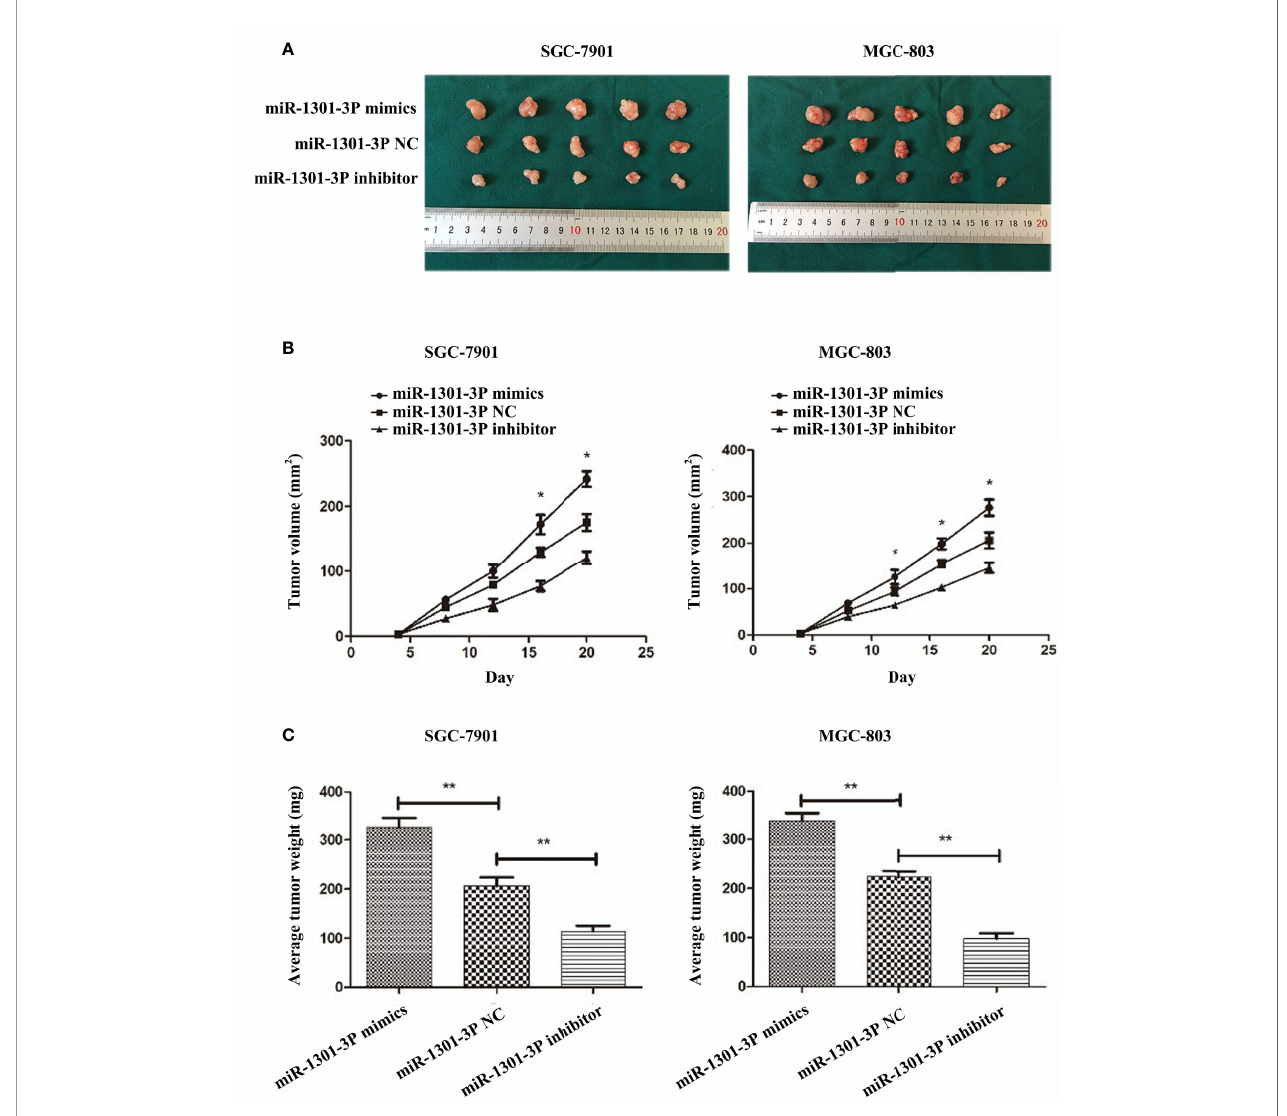
FIGURE 9 | miR-1301-3p facilitates tumor growth of GC cells in vivo . (A) GC cells SGC-7901 and MGC-803 transfected with miR-1301-3p mimics facilitated the tumor formation in the fl ank of nude mice, GC cells SGC-7901 and MGC-803 transfected with miR-1301-3p inhibitor retarded the tumor formation in the fl ank of nude mice. (B, C) The graphs represented the growth tendency of tumors 3 weeks after inoculation. The volume and weight of tumors were calculated. *p < 0.05, **p <